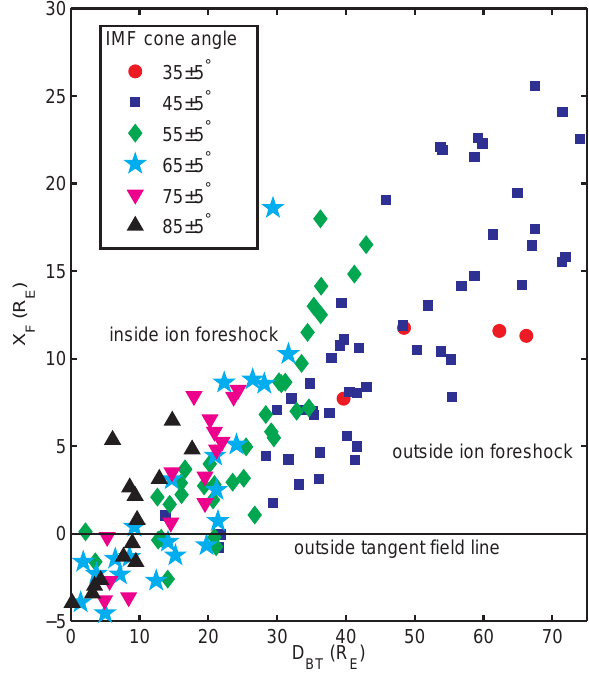
Fig. 5. Scatter plot of the location of foreshock cavities in the Solar Foreshock Coordinate system (see Figure 4). Solid symbols show cavity observation locations. Events have been sorted by the cone angle between the IMF and the GSE x axis; bins are indicated by colour. The X F = 0 line corresponds to the tangent field line. Events having X F < 0 were observed upstream of the field line tangentially intersecting the nominal bow shock. For other foreshock boundaries, studies (Greenstadt et al., 1968; Meziane and d’Uston, 1998) have not found a single line of demarcation that applies over a variety of upstream conditions. However, Figure 6 compares the location of some foreshock cavities to appropriate foreshock boundary fits. Note that the upper-left region in these figures corresponds to positions deep within the ion foreshock, whilst the lower-right part maps to regions upstream of the foreshock.